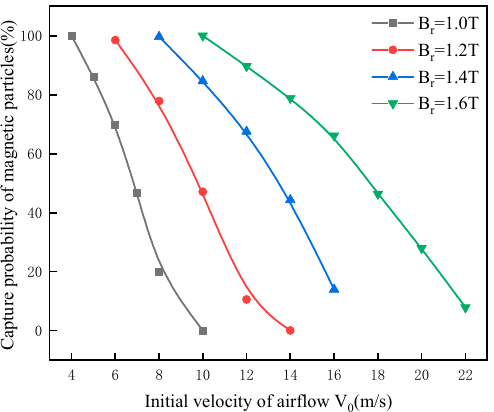
Figure 15. H ·∇ H value of N-N arrangement ( a ) and N-S arrangement ( b ) ( B r = 1.2 T).